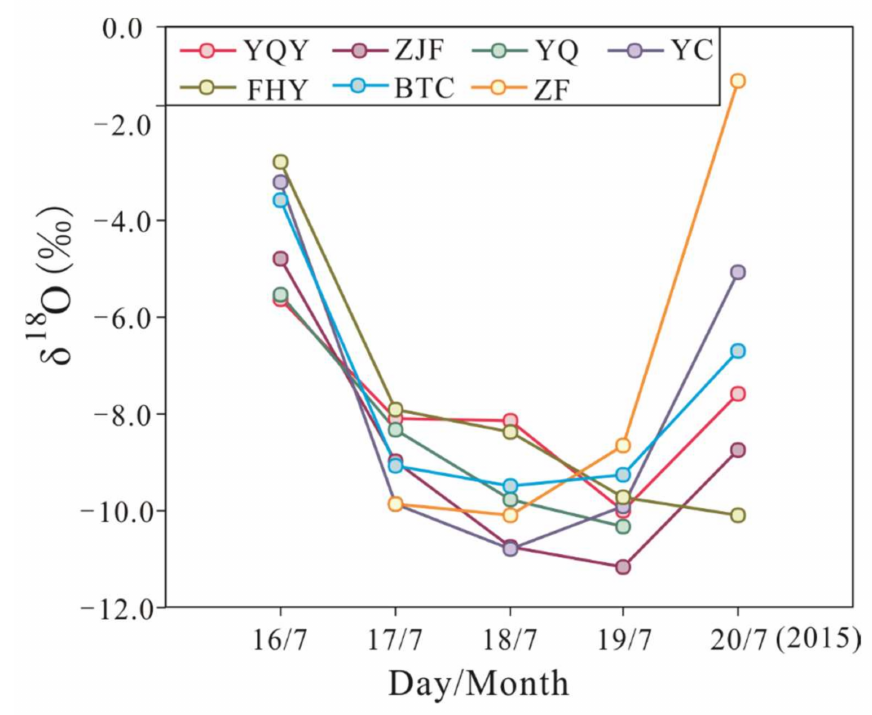
Figure 7. The isotopic variations in continuous precipitation events at seven stations over the Beijing region.